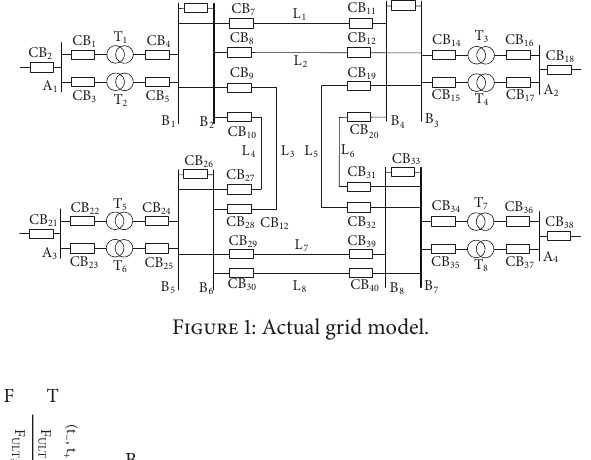
Figure 1: Actual grid model.